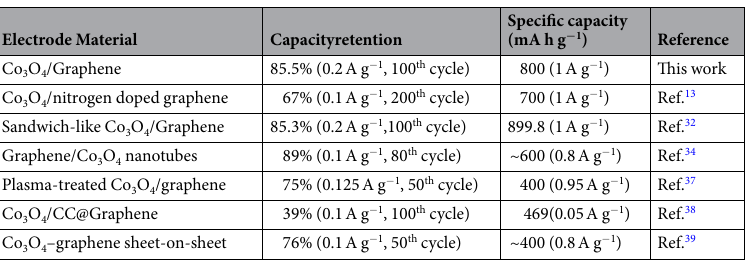
Table 1. Comparison of electrochemical performance of anode materials based on Co 3 O 4 and